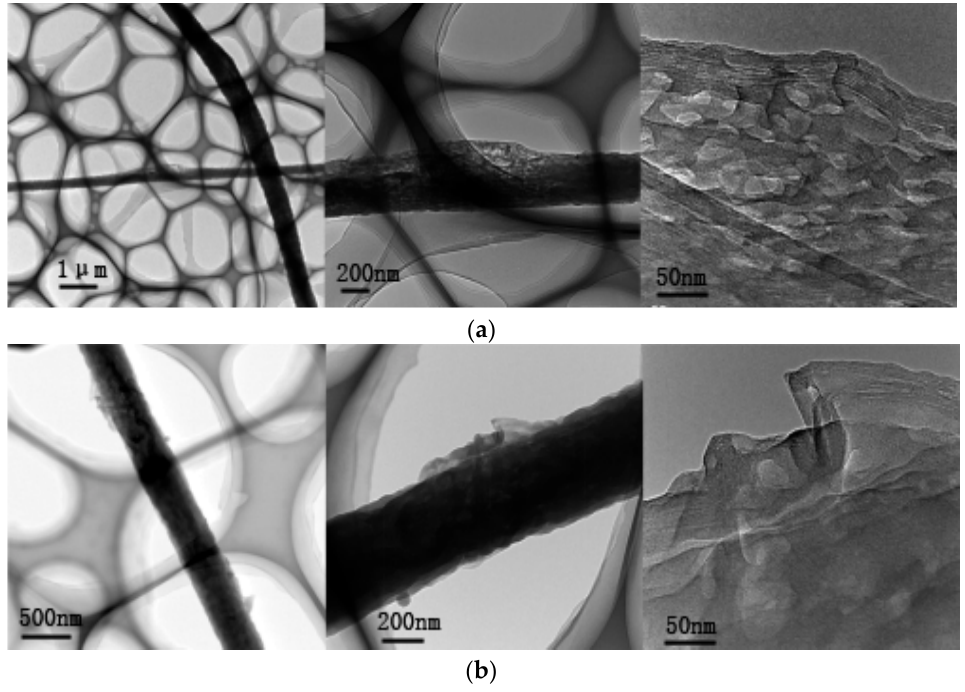
Figure 4. Transmission electron microscopy (TEM) photographs of the composite nanofibers with different SWCNT content. ( a ) 1 wt %; ( b ) 2 wt %.